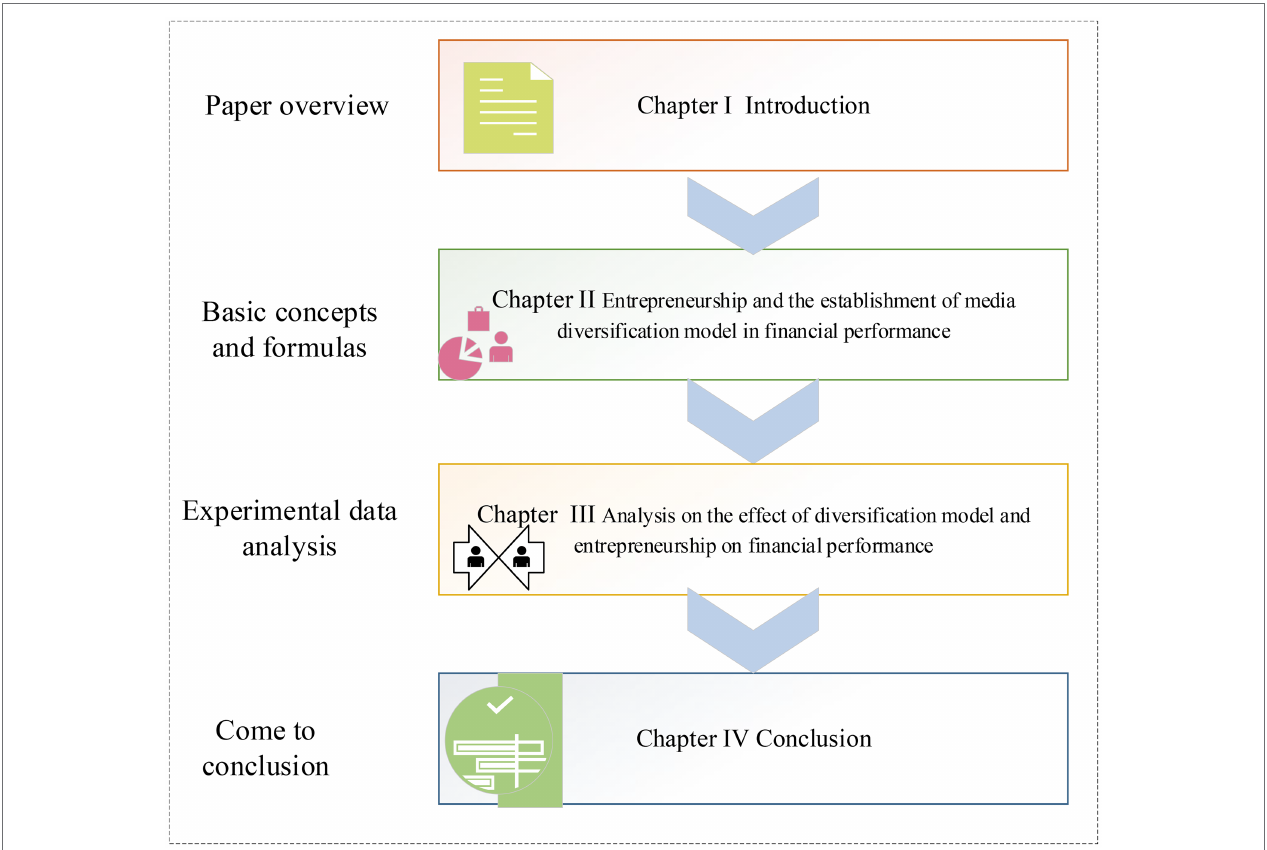
FIGURE 1 | Organizational structure.